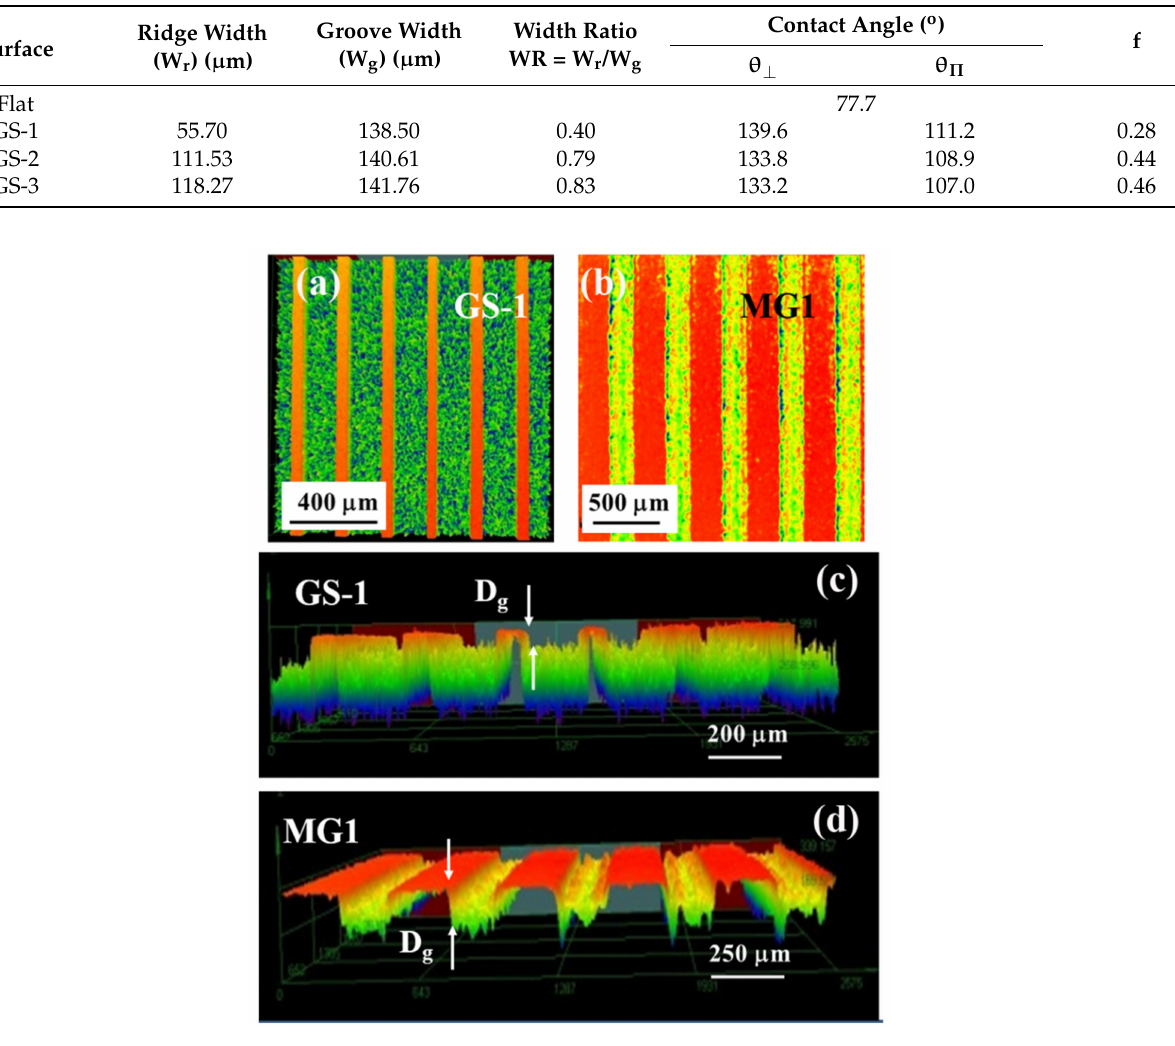
Figure 10. Optical profilometry images of ( a ) GS-1 top view, ( b ) MG1 top view, ( c ) GS-1 side view and ( d ) MG1 side view. D g is the groove depth. D g of GS-1 is 58 µ m (data from [6]) and that of MG1 is 100 µ m (present